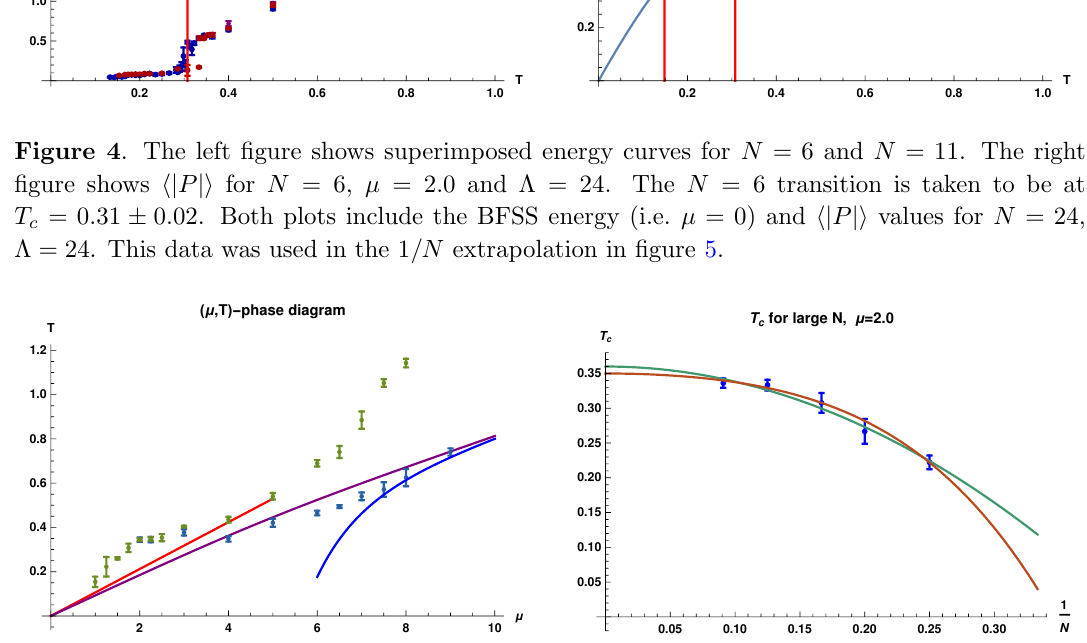
Figure 5 . The left (cid:12)gure shows data for the two observed phase transitions. The green points are the observed values of the Myers transition and the dark blue points are the Polyakov transition, both were measured for N = 8 and (cid:3) = 24. The blue curve is the large (cid:22) expansion of the critical temperature to three loops. The red line is the gauge gravity prediction and the purple curve is the Pad(cid:19)e approximant obtained from the large mass expansion. The (cid:12)gure on the right shows our extrapolation of the critical temperature of the Myers transition from the observed values for N = 4 ; 5 ; 6 ; 8 and N = 11 for (cid:22) = 2 : 0 and (cid:3) = 24. We use a quadratic extrapolation (green), given by 0 : 36 (cid:0) 2 : 17 x 2 and quartic (red) given by 0 : 35 (cid:0) 1 : 09 x 2 (cid:0) 15 : 26 x 4 , which gives T c ( 1 ) = 0 : 35 (cid:6) 0 :